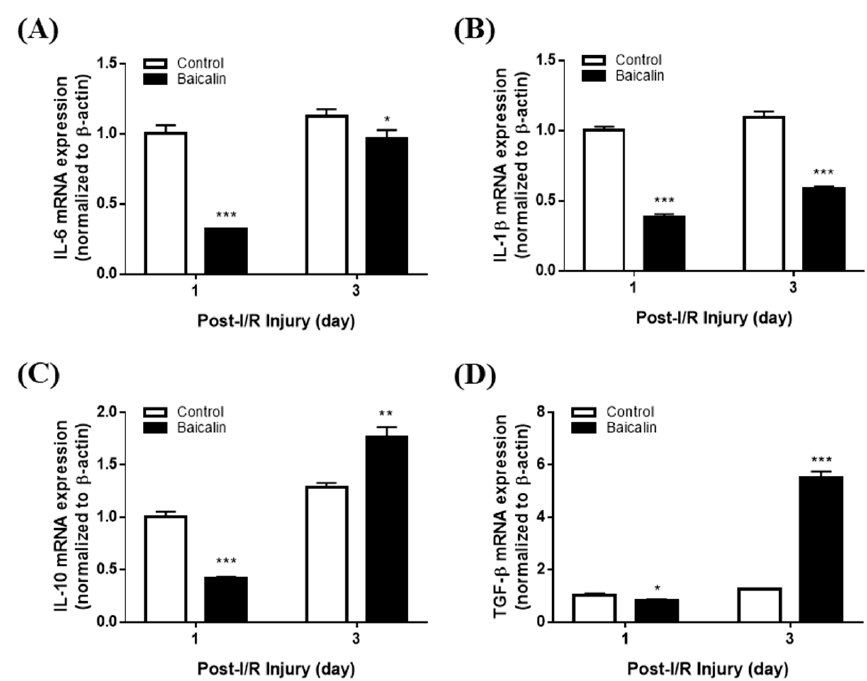
Figure 6. Relative mRNA expression levels of ( A ) IL-6, ( B ) IL-1 β , ( C ) IL-10, and ( D ) TFG- β in mice with pressure ulcers. Baicalin suppresses pro-inflammatory cytokines and promotes anti- inflammatory mediators such as TGF- β in a pressure ulcer mouse model. All data are expressed as mean ± SD from three independent experiments. * p < 0.05, ** p < 0.01, *** p < 0.001. IL, interleukin; TGF- β , transforming growth factor- β